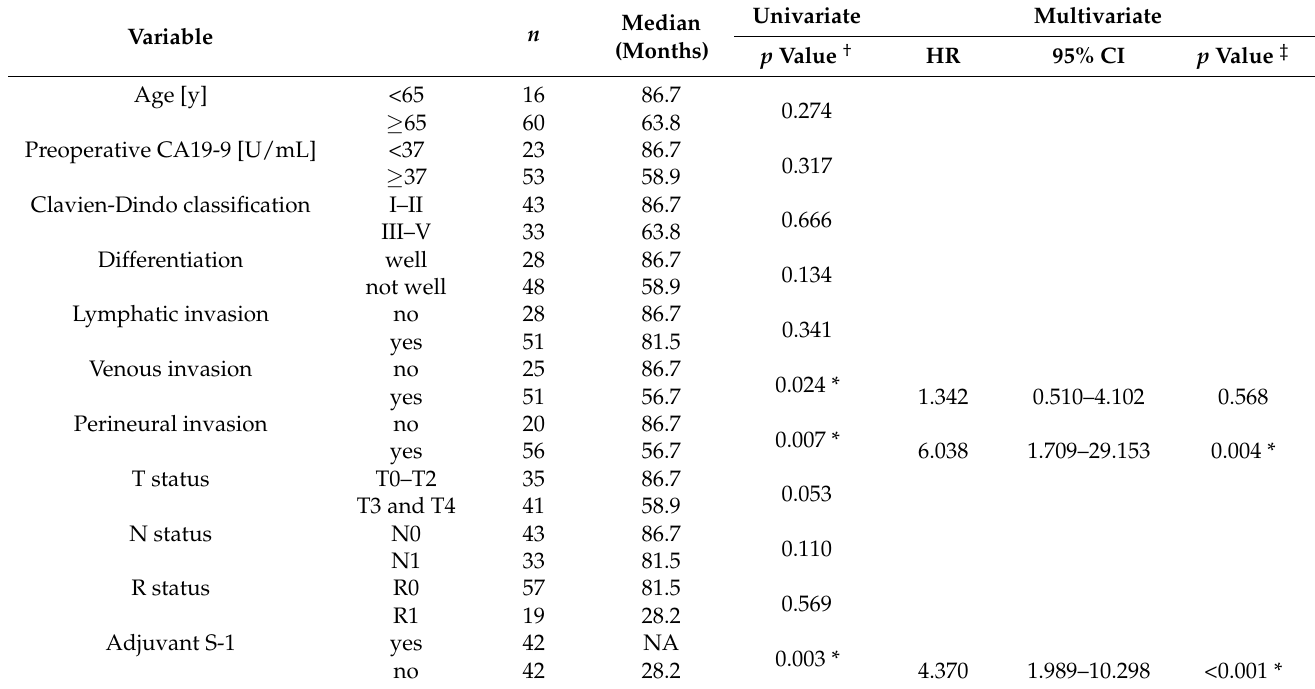
Table 3. Univariate and multivariate analysis of overall survival in the matched cohort.